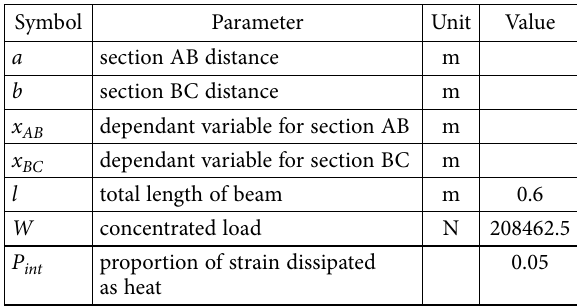
Table 2. Temperature/strain parameters, symbols and common values